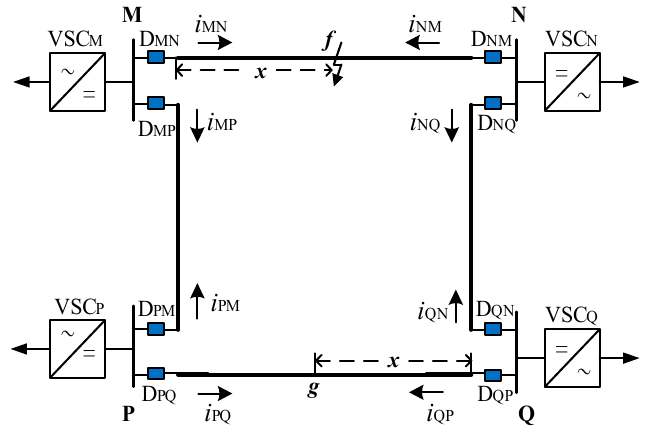
Figure 6. Schematic diagram of VSC based four-terminal DC F igure 6. Schematic diagram of VSC based four-terminal DC grid